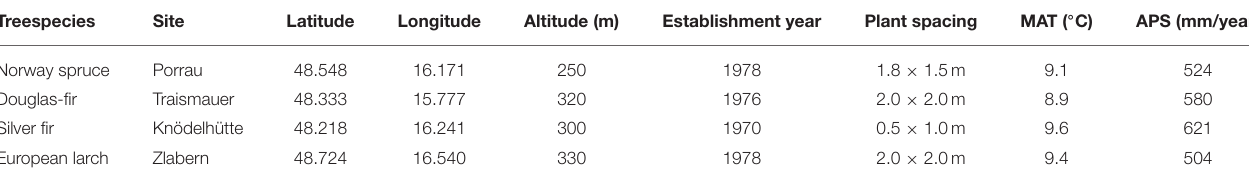
TABLE 1 | Trial sites and basic climate descriptors of trial sites in Eastern Austria. Treespecies